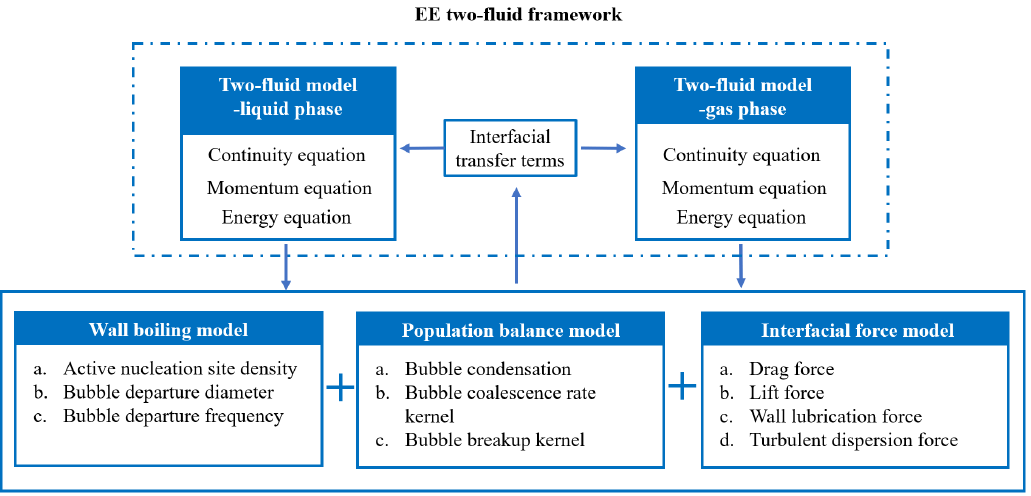
Figure 1. Illustration of wall nucleation model coupled with PBM kernel in EE two-fluid framework for gas-liquid flow.